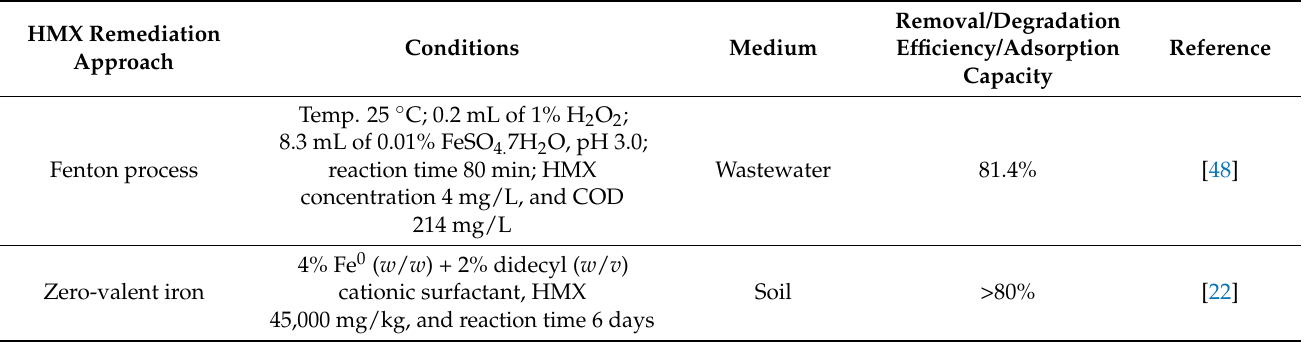
Table 2. Physicochemical remediation approaches for HMX